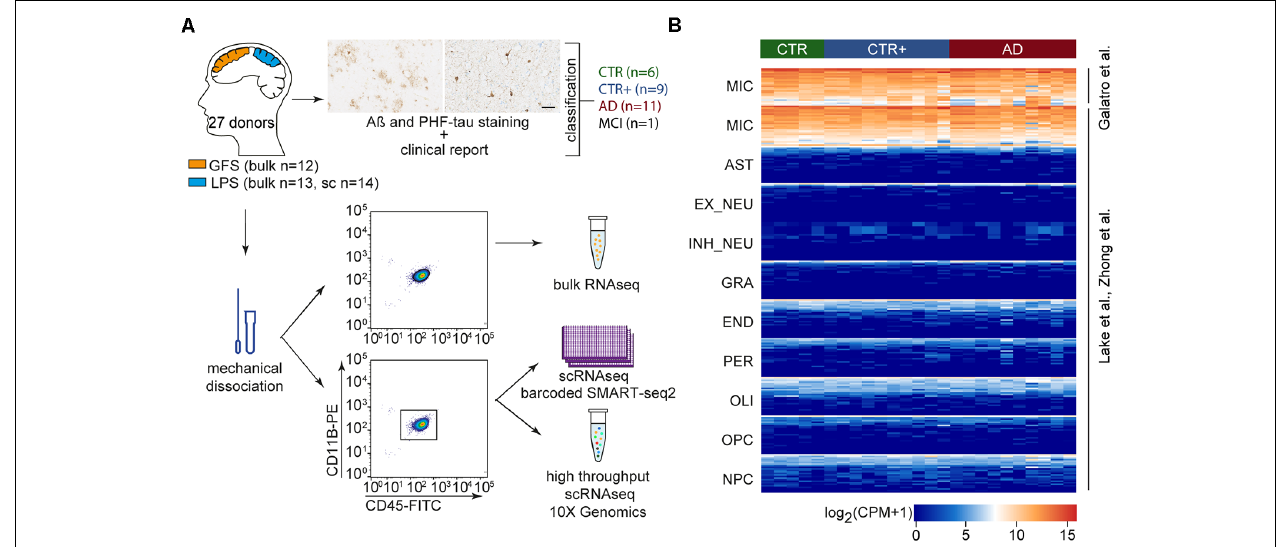
FIGURE 1 | Microglia gene expression profiling of four groups of donors from acute postmortem human brain tissue. (A) Tissue samples from GFS and LPS were classified into four experimental groups (CTR, CTR+, AD, MCI) based on A β and PHF-tau immunohistological stainings and the clinical report of the donor (scale bar = 50 µ m). Microglia were mechanically isolated and collected by CD11B+CD45+-based FACS sorting. Sorted microglia were used for bulk or single-cell sequencing (barcoded Smartseq2 and 10 × Genomics sequencing techniques). (B) Heat map depicting log 2 CPM expression of cell type-specific markers in bulk-sorted microglia, as previously published in different data sets (Lake et al., 2016; Galatro et al., 2017a; Zhong et al., 2018). Abbreviations: AD, clinically diagnosed Alzheimer’s Disease; AST, astrocytes; A β , amyloid beta; CPM, counts per million; CTR, Control; CTR+, Control with A β plaques and/or hyperphosphorylated tau; END, endothelial cells; EX_NEU, excitatory neurons; GFS, superior frontal gyrus; GRA, granulocytes; IN_NEU, inhibitory neurons; LPS, superior parietal lobe; MCI, mild cognitive impairment; MIC, microglia; NPC, Neural Progenitor Cells; OLI, oligodendrocytes; OPC, Oligodendrocyte Precursor Cells; PER, pericytes; PHF-tau, hyperphosphorylated tau; scRNAseq, single-cell RNA